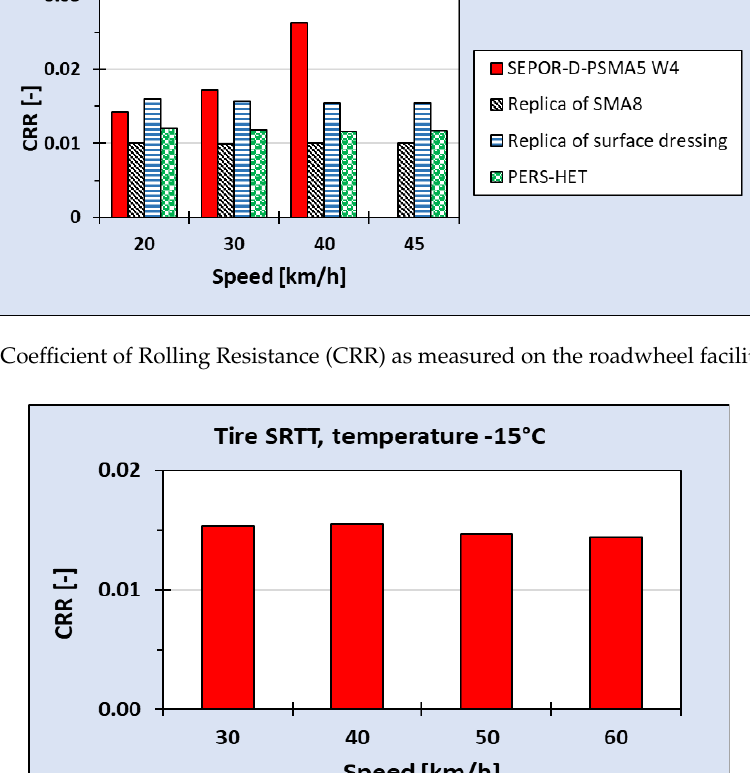
Figure 28. Coefficient of Rolling Resistance (CRR) for SEPOR-D-PSMA5 W4 and reference pavement SMA8 measured at the Dąbrówka section.